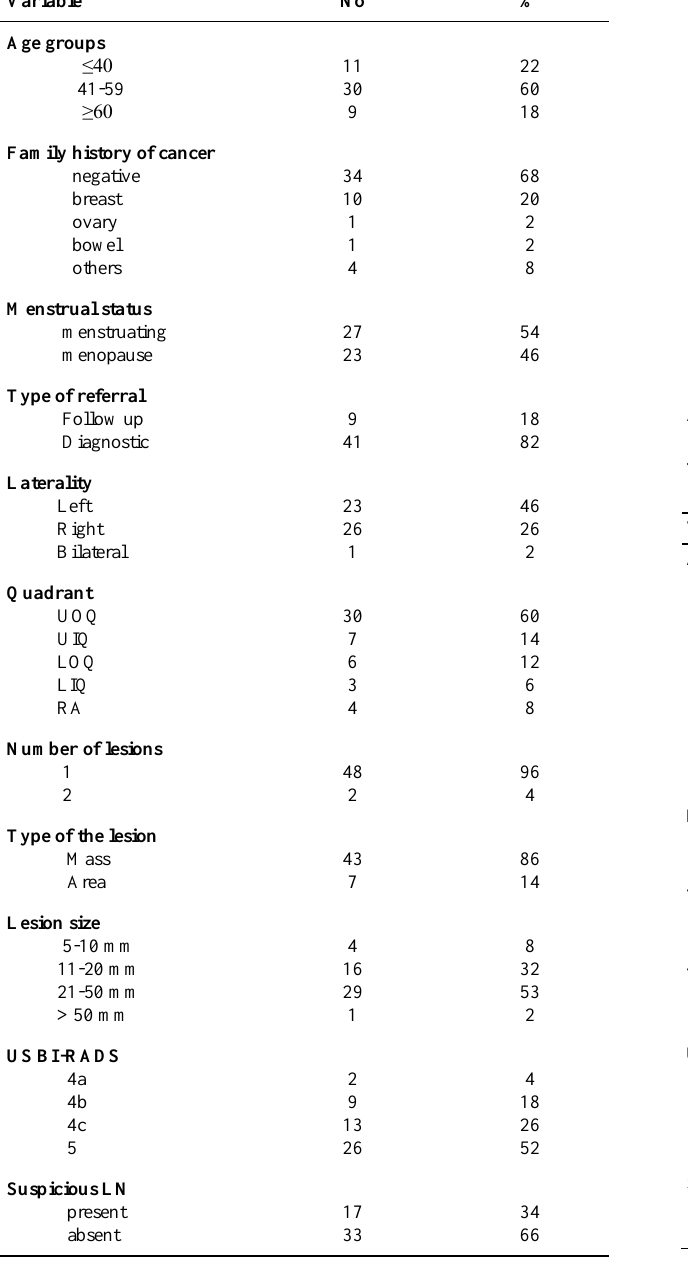
Table 1: Patients’ characteristics and ultrasound lesions features